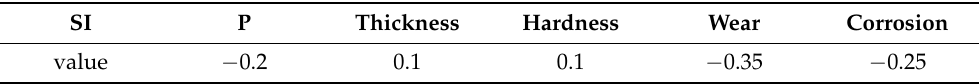
Table 7. Synthesis indicator (SI) values employed in the multivariate optimization. SI